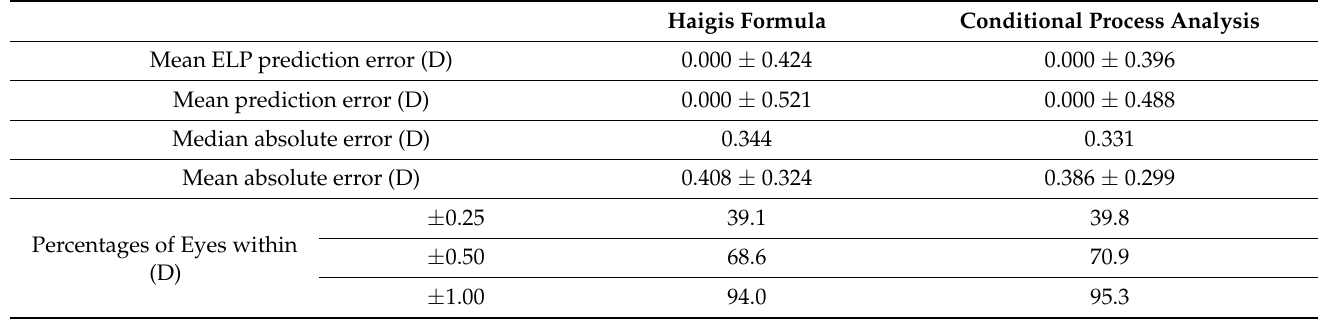
Table 5. Predictive outcomes derived from the Haigis formula and conditional process